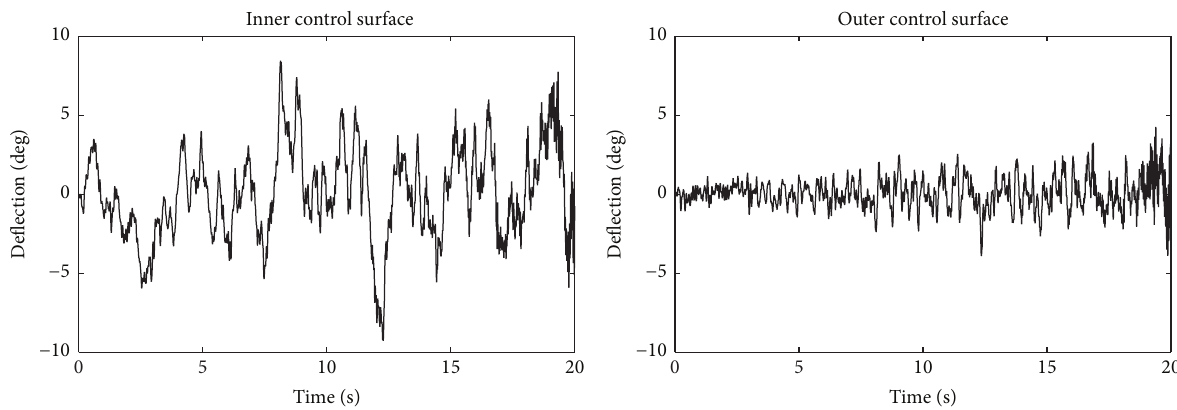
Figure 9: Time response of control surfaces deflection to wind-gust input as Ma and 𝑞